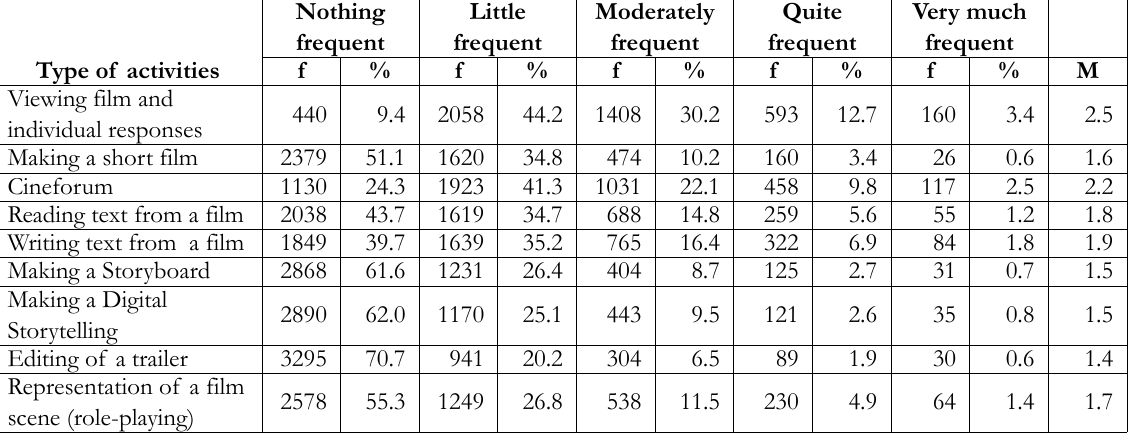
Table 5. Percentages and frequency of activities in the Teacher’s Degree with cinema as a didactic